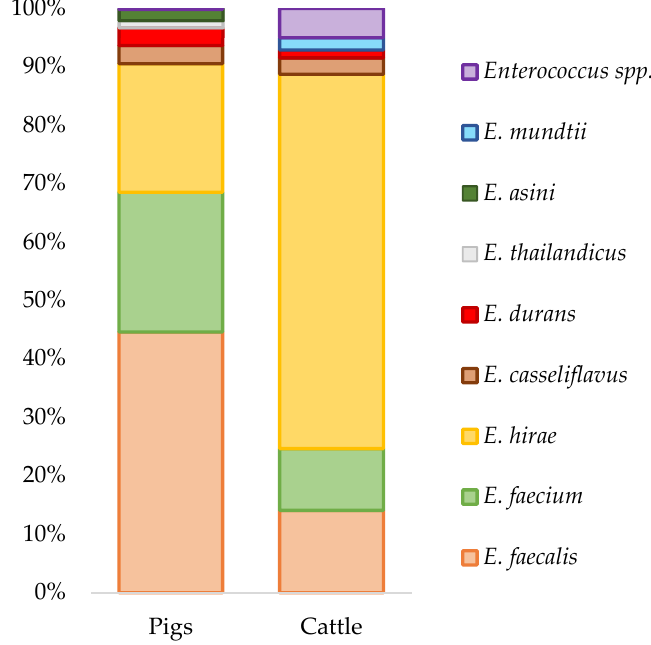
Figure 1. Distribution of Enterococcus species in cattle and pigs.